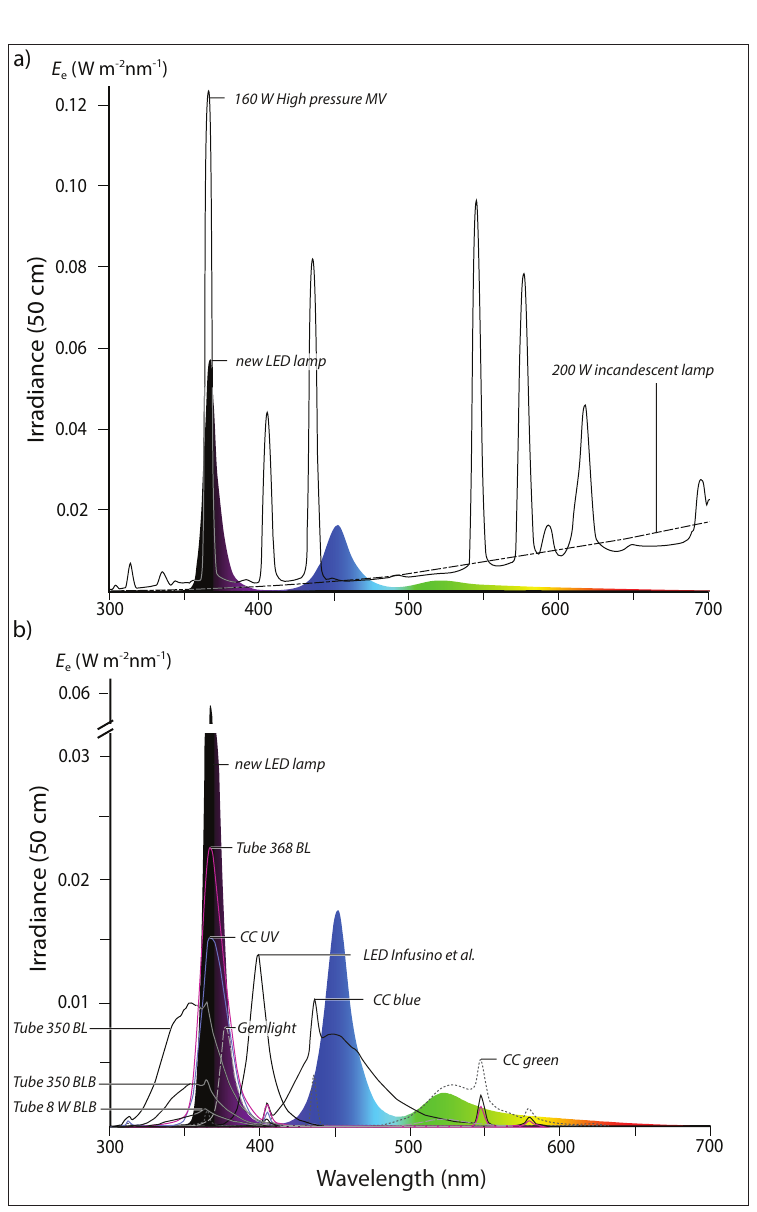
Figure 5. Irradiance from the new LED lamp (in colour), compared with other lamps. a. Compared with irra- diation from a 190 W high-pressure mercury vapour (MV) bulb with tungsten filament (black line), and a 200 W incandescent lamp with tungsten filament (dashed black line). b. Irradiance from the new LED lamp (in co- lour), as compared to irradiance from various commonly used lamps used for insect collecting. CC blue: Blue cold cathode; CC green: Green cold cathode; CC UV: ultraviolet cold cathode; tube 350: low pressure actinic mercury vapour tube with 350 nm emission peak; tube 350 BL: low pressure mercury vapour blacklight tube with 350 nm emission peak; tube 368: low pressure mercury vapour tube with 368 nm emission peak. Gem- Light: GemLight UV LED at 0°. LED Infusino et al.: 400 nm LED stripe applied by Infusino et al.